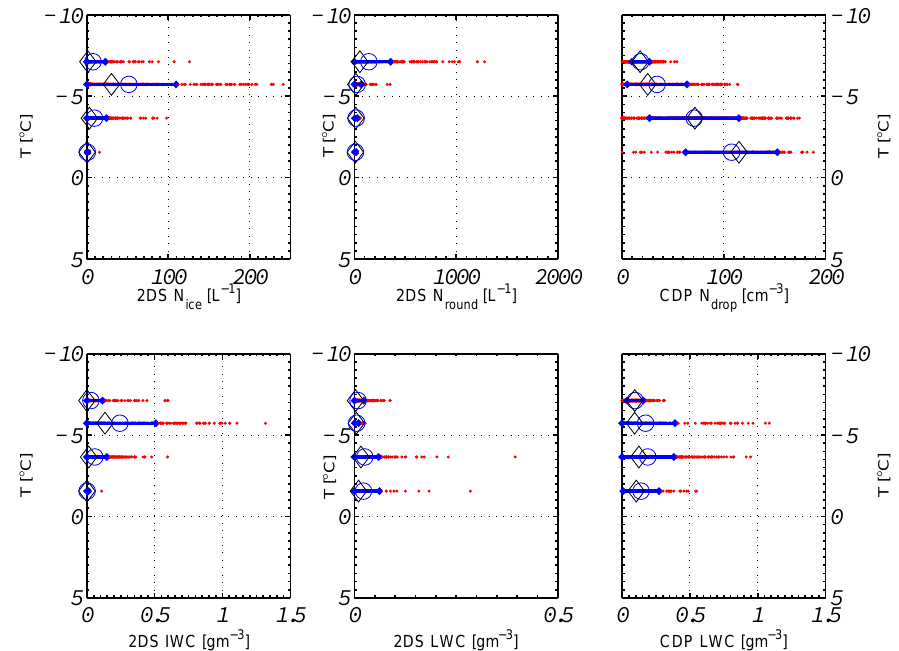
Fig. 3. In situ cloud particle number concentrations and ice and liquid water contents from flight B425, runs R1 to R7, as a function of ambient temperature. Red dots indicate a single 1Hz data point; the black diamond is the median for the run and the large blue circle is the mean. The two smaller interconnected blue circles are one standard deviation from the